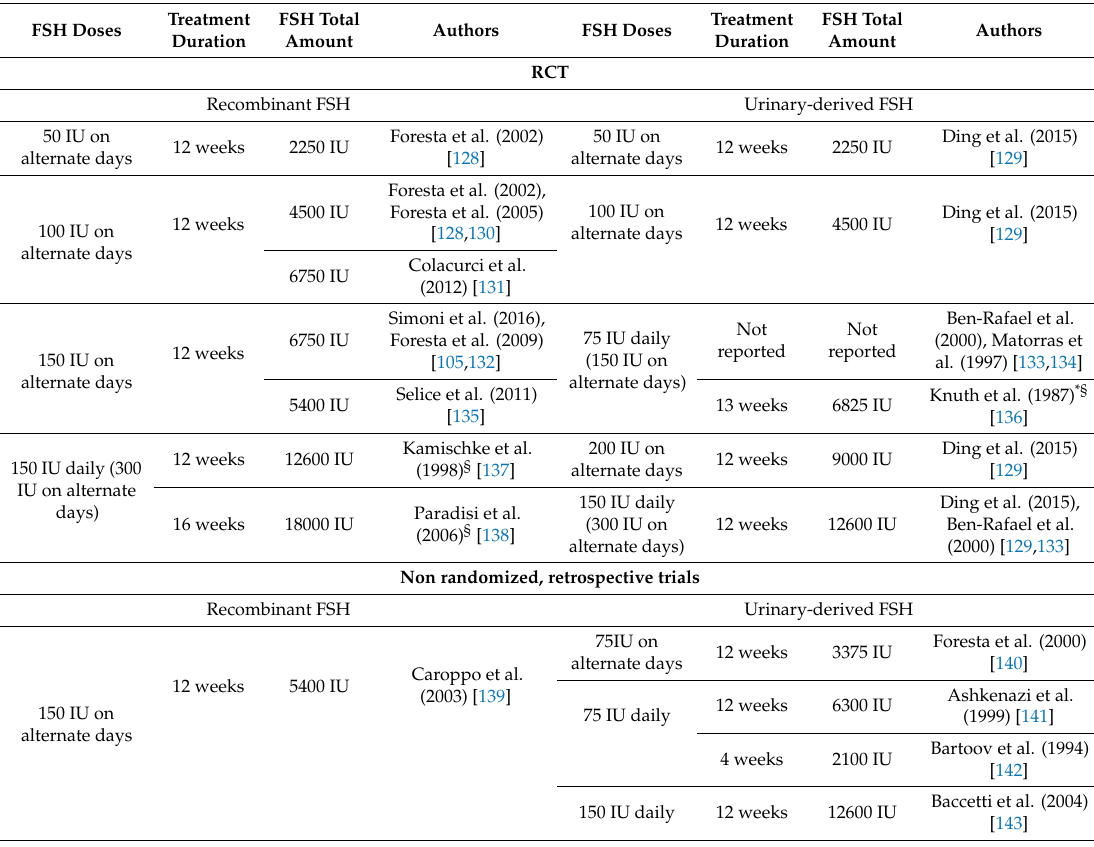
Table 1. Clinical trials available in the literature evaluating the e ffi cacy of follicle-stimulating hormone (FSH) in male idiopathic infertility. Studies are classified considering the study design and the therapeutic dosage